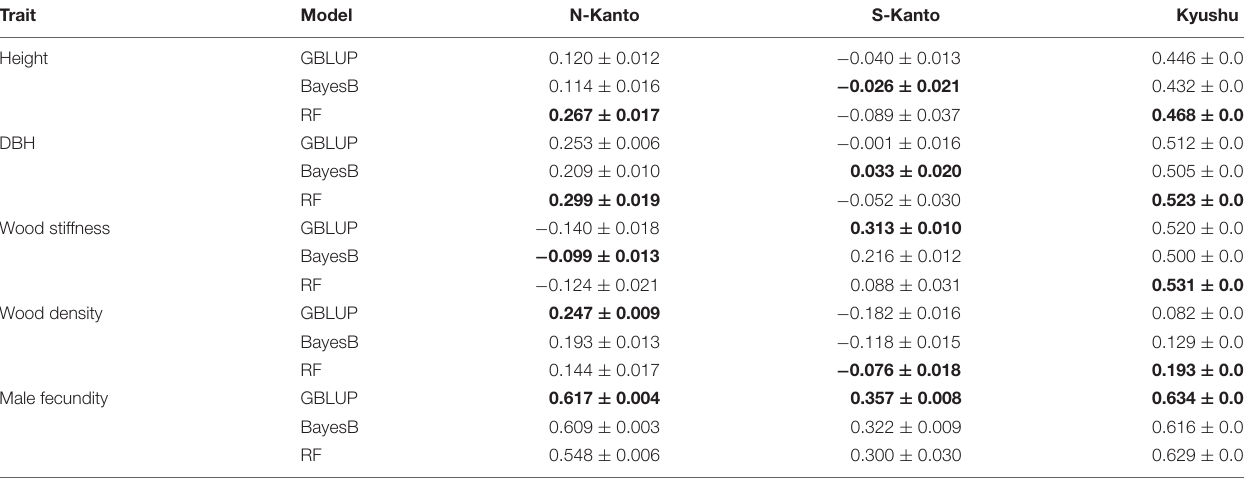
Highest value in each trait and population combination is in bold.